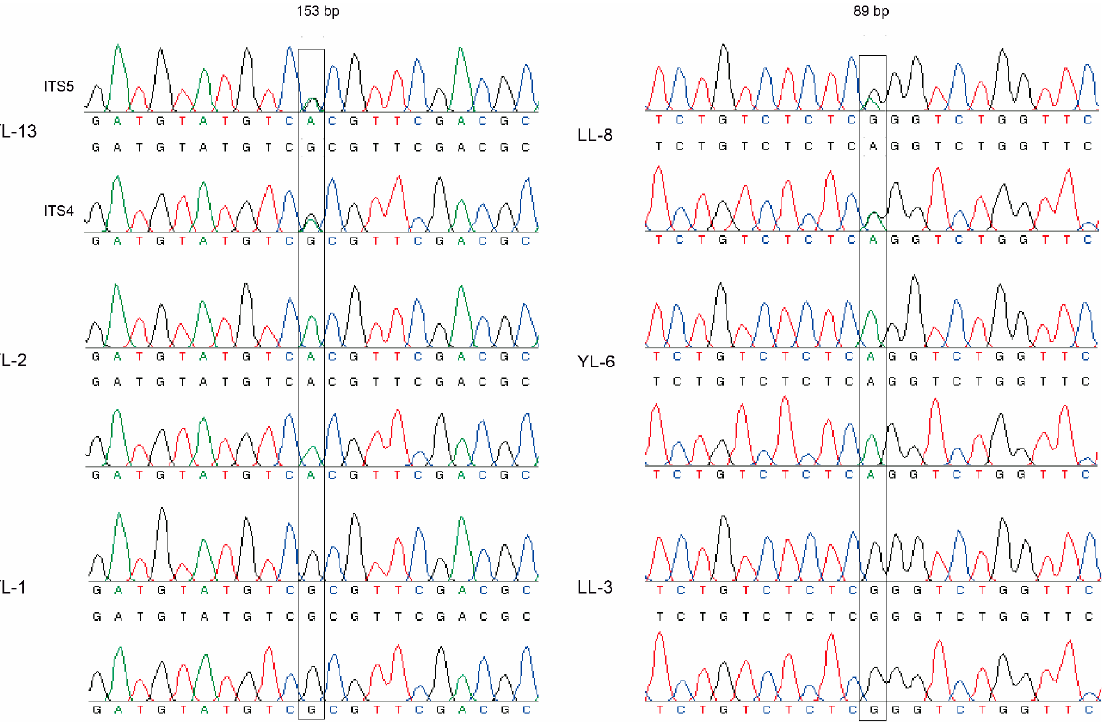
Figure 2. Chromatographs with clear ITS heterozygosity. Notes: Each sample had two chromatographs in different directions, the upper one was from the forward primer ITS5, and the lower chromatograph was from the reverse primer ITS4. “153 bp” and “89 bp” indicate the heterozygous position, and different colored peaks represented different nucleotide bases (black: G; green: A; blue: C; red: